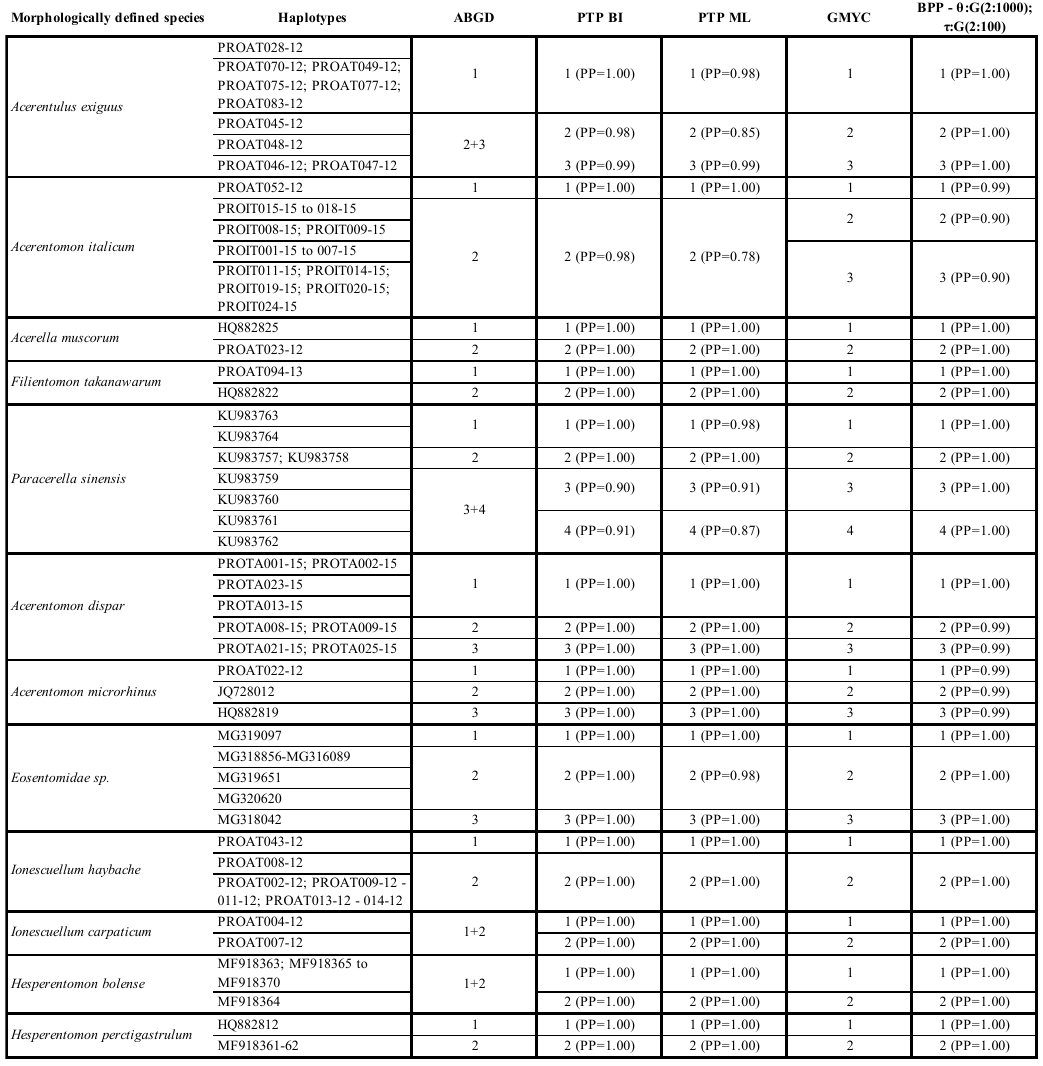
Table 3. Species delimitation analysis ( cox1 ). Only morphological species that have been subdivided in two or more sublineages by at least one species delimitation method are included, see Supplementary Table 3 for full information. First column lists species as morphologically defined following BOLD annotations. Second column reports BOLD identifiers for each specimen; specimens sharing the same cox1 haplotype (after alignment trimming) are grouped using thin horizontal lines. Columns 3 to 7 show results of different analyses for species delimitation; an open cell indicates a cluster of the corresponding specimens listed in the second column; open cells carry a numerical indication of the corresponding sublineage (for cross table reference) and (where applicable) statistical support for the group expressed as posterior probabilities; in BPP, only results associated with the intermediate parameter combination are shown, see Table S3 for full information.